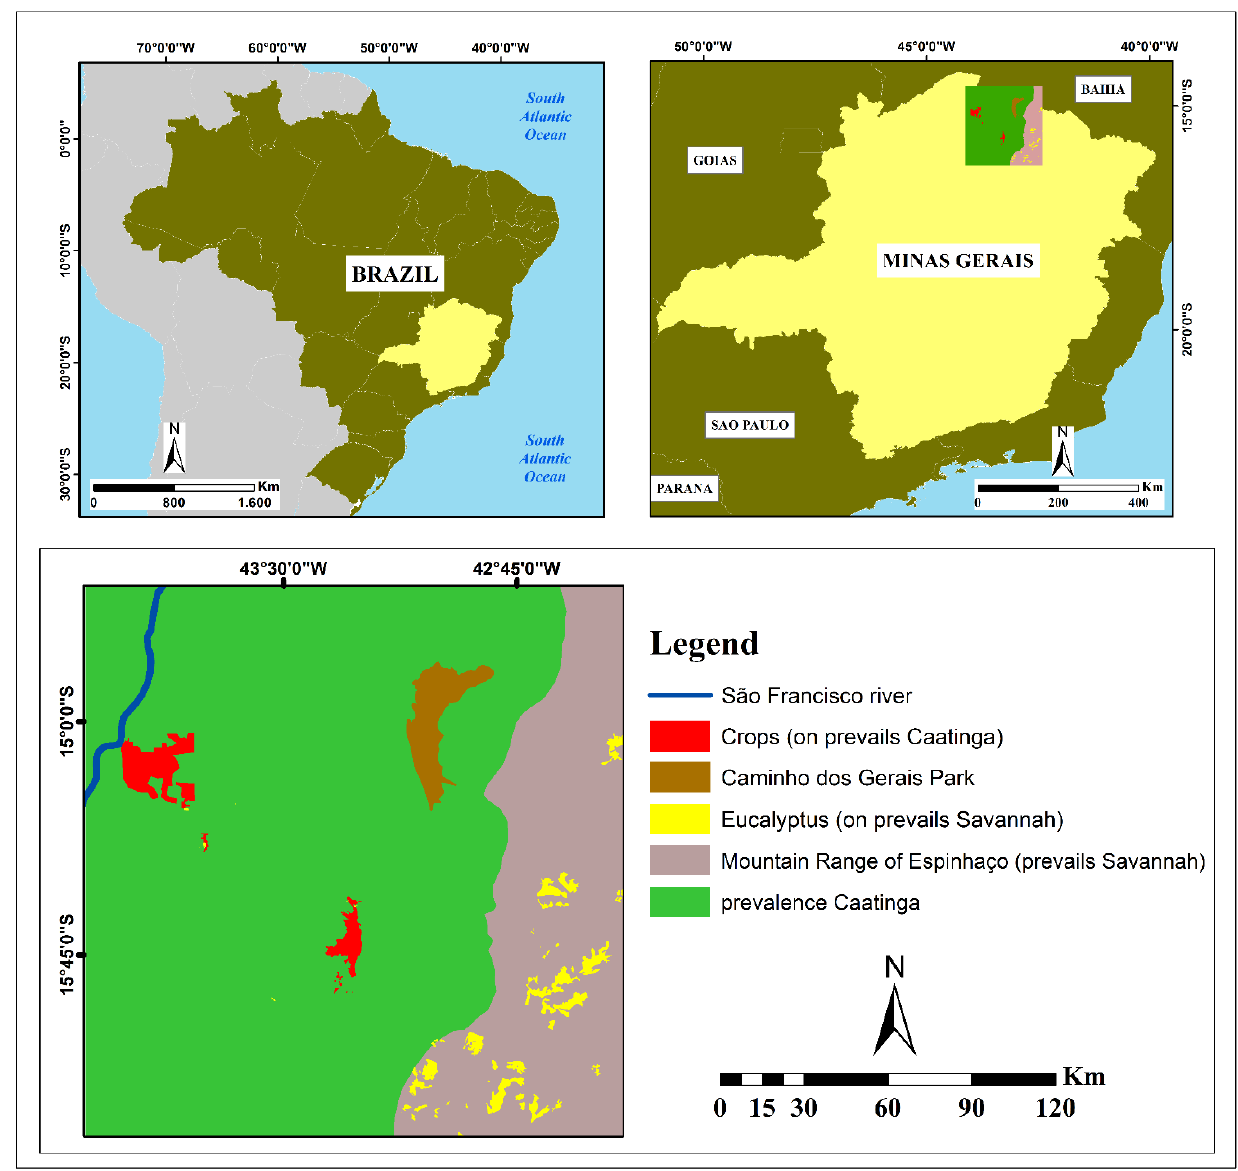
Figure 1. Location map of the study area, with the spatial distribution of Caatinga and Cerrado domains